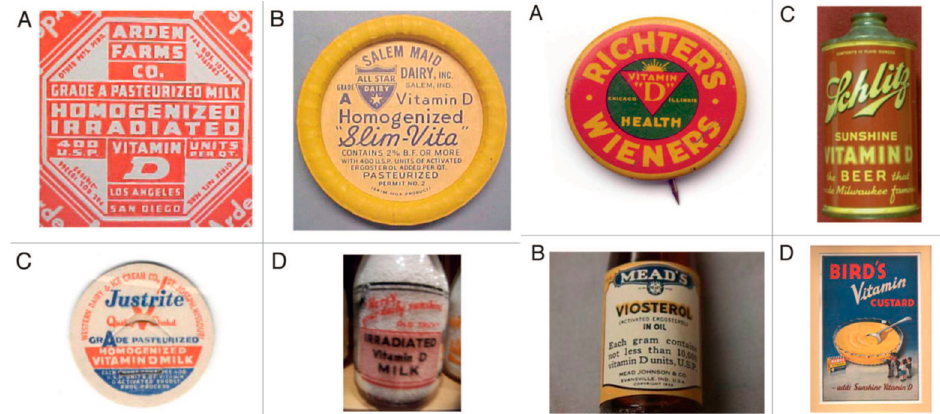
Figure 6. ( Left panel ). ( A ) Seal of a milk bottle that denoted that the milk was irradiated with UV radiation and contained vitamin D. ( B ) Cap of a milk bottle stating that activated ergosterol had been added to the milk. ( C ) Cap of milk bottle stating that the milk had been fortified with vitamin D. ( D ) Seal of a bottle of milk that denoted that the milk had been irradiated and contained vitamin D. Holick, copyright 2013. Reproduced with permission. ( Right panel ) ( A ) Seal denoting that this product was fortified with vitamin D. ( B ) Bottle of oil denoting that it contained irradiated ergosterol. ( C ) Beer can denoting that it was fortified with vitamin D. ( D ) Advertisement denoting that Bird’s custard contained vitamin D. Ref. [8] Holick, copyright 2013. Reproduced with permission.